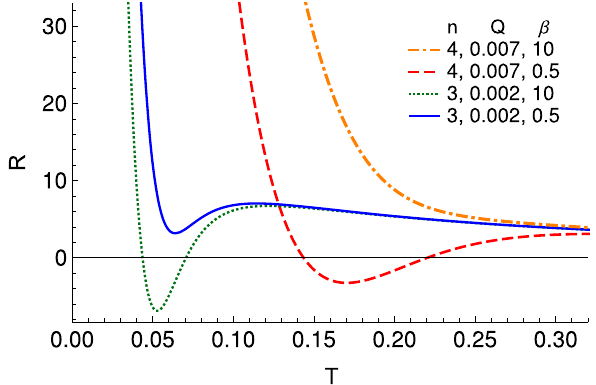
Fig. 11 The behavior of the Ruppeiner invariant R , H M Q = 0 . 018